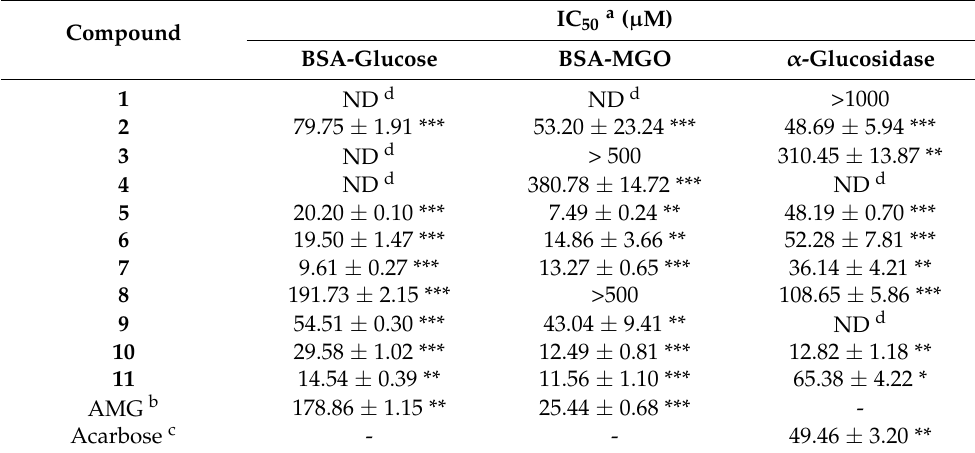
Table 2. IC 50 (inhibitory activity) of compounds 1 – 11 against AGE formation in BSA-glucose and BSA-MGO systems and α